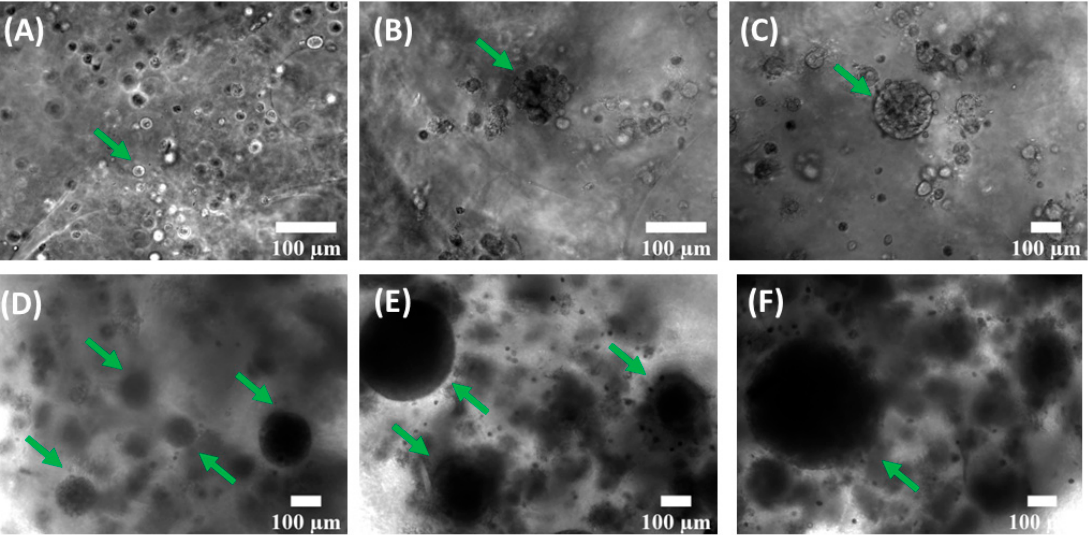
Figure 3. HeLa spheroid formation in a 3D alginate matrix, printed according to the optimized procedure, during four weeks of culture. ( A ) HeLa cell distribution and organization 1 day after printing; the green arrow indicates a single cell. ( B ) Representative example of cellular organization at 7 days after printing; the green arrow indicates an area where spheroid organization is starting. ( C ) 3D bioprinted matrix 10 days after printing: the green arrow indicates a HeLa spheroid. ( D , E ) 18 days ( D ) and 23 days ( E ) after printing; the green arrows indicate spheroids. HeLa spheroids are increasing, both in number and average dimensions. ( F ) HeLa spheroids and surrounding matrix 32 days after printing: a green arrow indicates a spheroid with a diameter of 470 µm; the degree of cellularization of the sample ulteriorly increases.